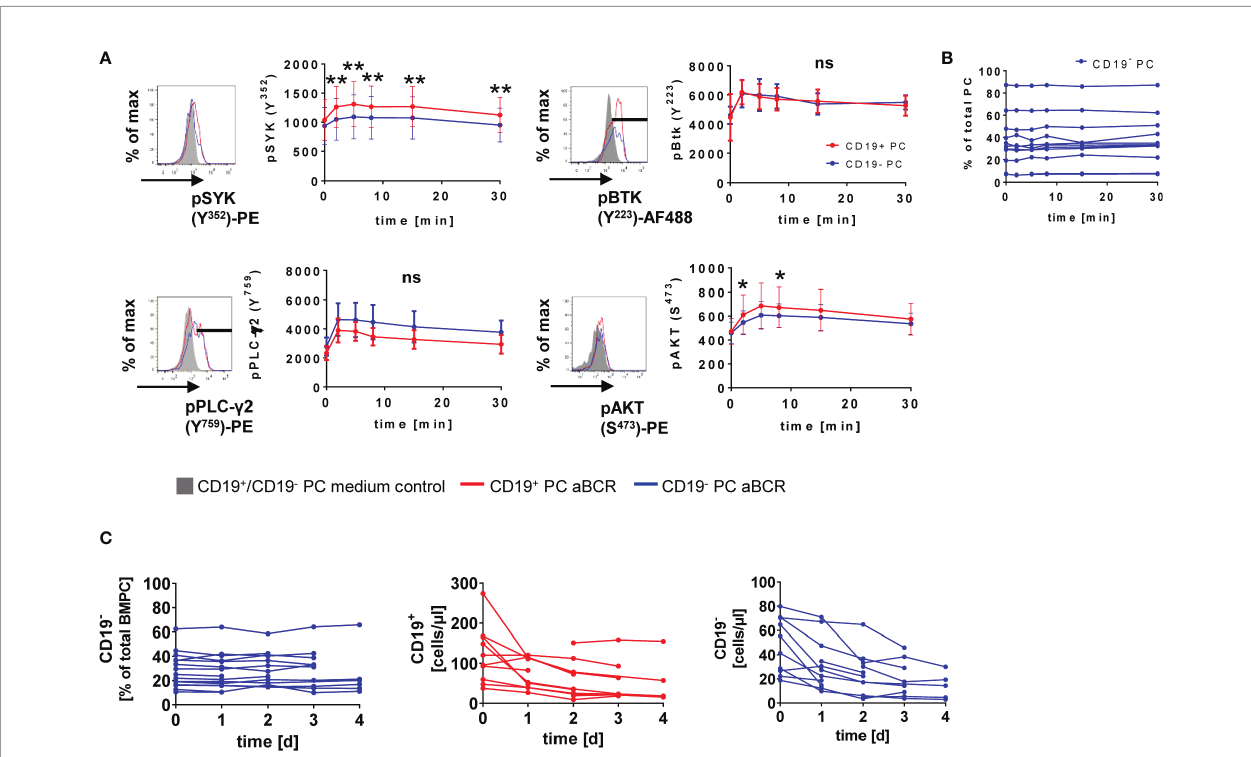
FIGURE 2 | CD19 + and CD19 − BMPC respond to BCR stimulation. (A) MNCs isolated from the BM were stimulated with 30 µg/ml anti-BCR F(ab) 2 IgM/IgG/IgA (aBCR) for the indicated times and stained intracellularly for the respective phosphosites of different PTKs or PSK. A representative histogram is shown for each pPTK/pPSK (5 ′ RPMI/5 ′ aBCR). For pSYK and pAKT, the median fl uorescence intensity of total CD19 + or CD19 − BMPCs is displayed. High expressors were gated for pBTK and pPLC- g 2 and the MFI is shown for this population. **p < 0.01, *p < 0.05 by Wilcoxon signed rank test. ns, not signi fi cant. pSYK: n = 10 (t = 15 min, n = 9); pBTK: n = 10; pPLC- g 2: n = 4; pAKT: n = 10. Data are presented as mean ± SD. (B) Frequency of CD19 − PC among total BMPC during short-term BCR kinetics. (C) BM MNCs were cultured for up to four days in the presence of 1 µg/ml anti-BCR F(ab) 2 IgM/IgG/IgA (aBCR) or medium (control). Frequency of CD19 − BMPC among total PC (n = 6 – 16) and absolute counts of CD19 + and CD19 − BMPC (n = 5 – 12) during the culture with